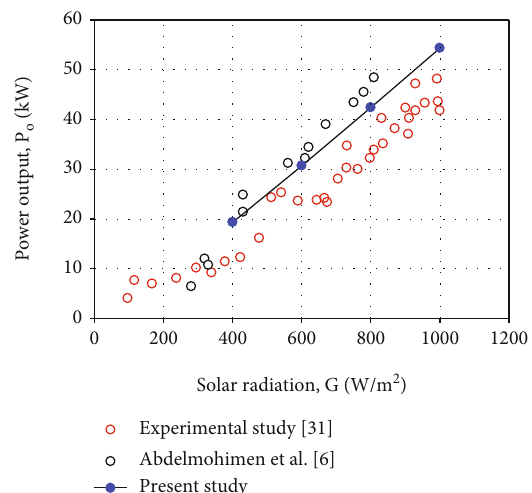
Figure 4: Accuracy justi fi cation of the CFD results over P under di ff erent solar